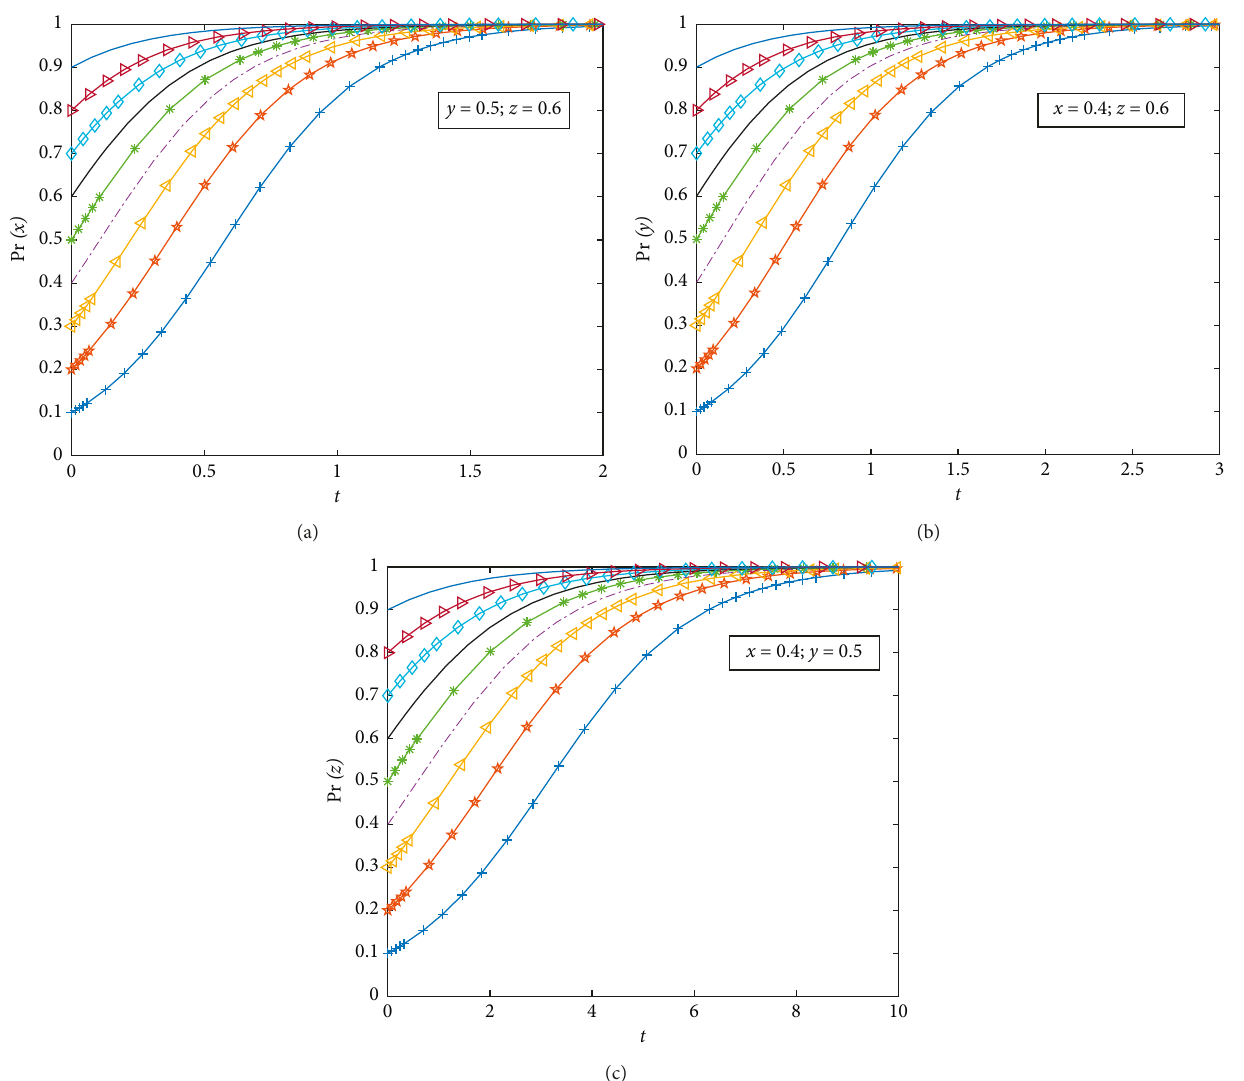
Figure 4: (a) The evolution curve of x when y � 0.5 and z � 0.6. (b) The evolution curve of y when x � 0.4 and z � 0.6. (c) The evolution curve of z when x � 0.4 and y �